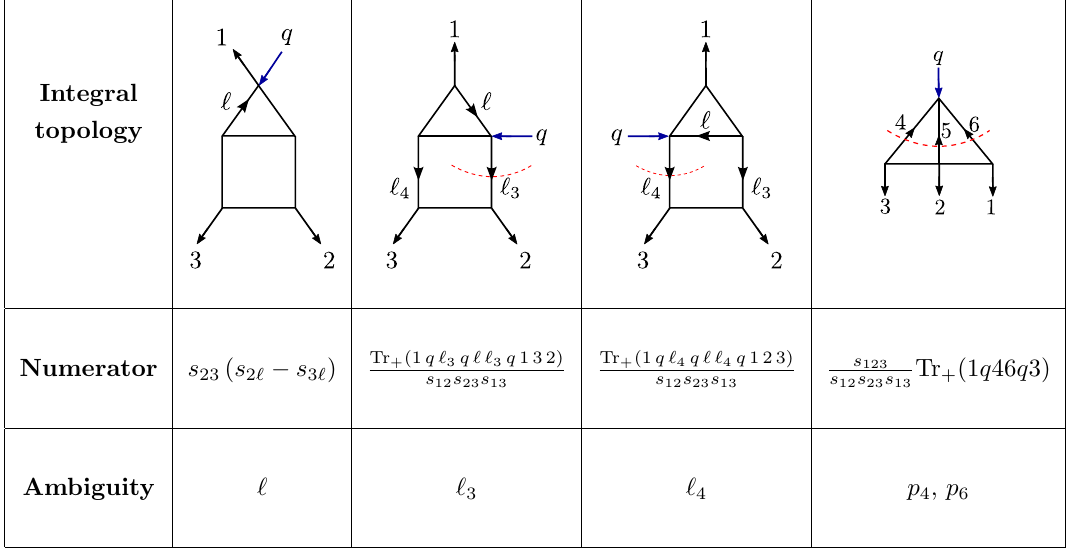
Table 2 . Summary of the result after the two-particle cuts and the three-particle cut in the q 2 - channel. All numerators have the tree-level form factor factored out. The propagators which are cut are still ambiguous given the cuts performed so